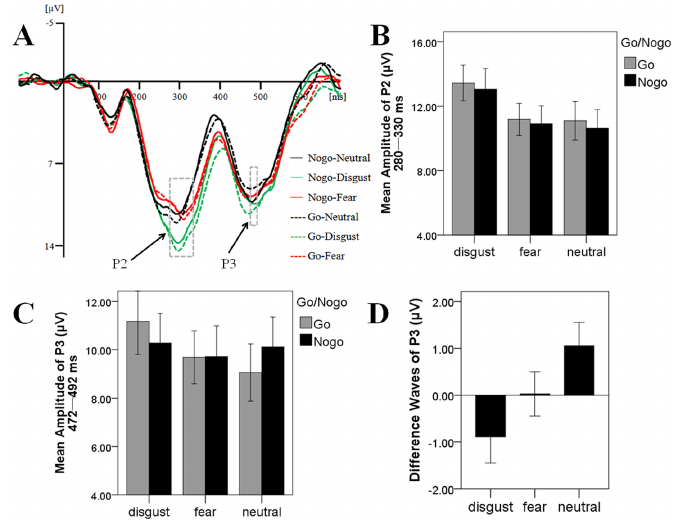
Fig 3. The ERP Results for Weakly Masked Condition. (A) The averaged ERP under different emotional contexts; (B) P2 amplitude under different emotional contexts; (C) P3 amplitude under different emotional contexts; (D) The difference waves (no-go condition minus go condition) of P3 amplitude under different emotional contexts.